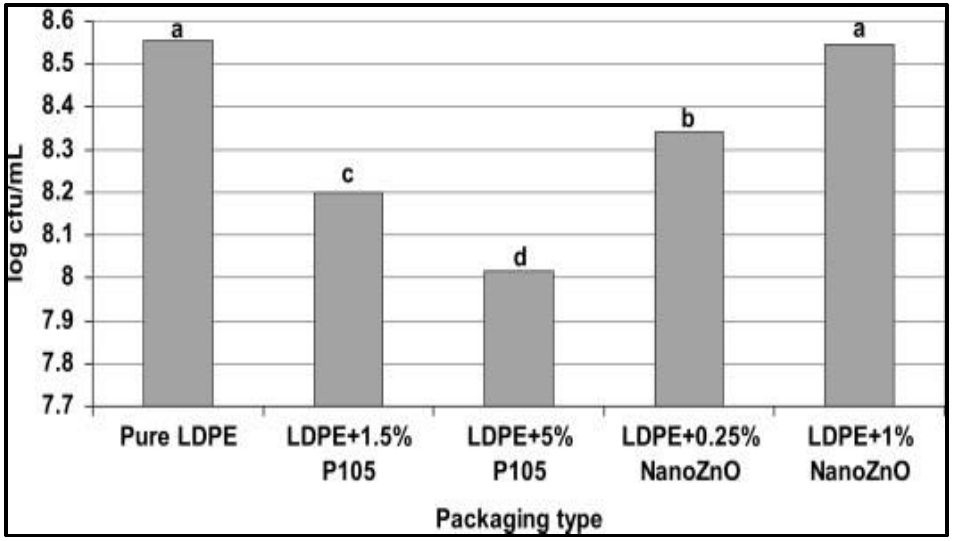
Figure 8. Effect of packaging type on inactivation of Lactobacillus plantarum . Reproduced from ref. [84] with permission from Elsevier. 2011